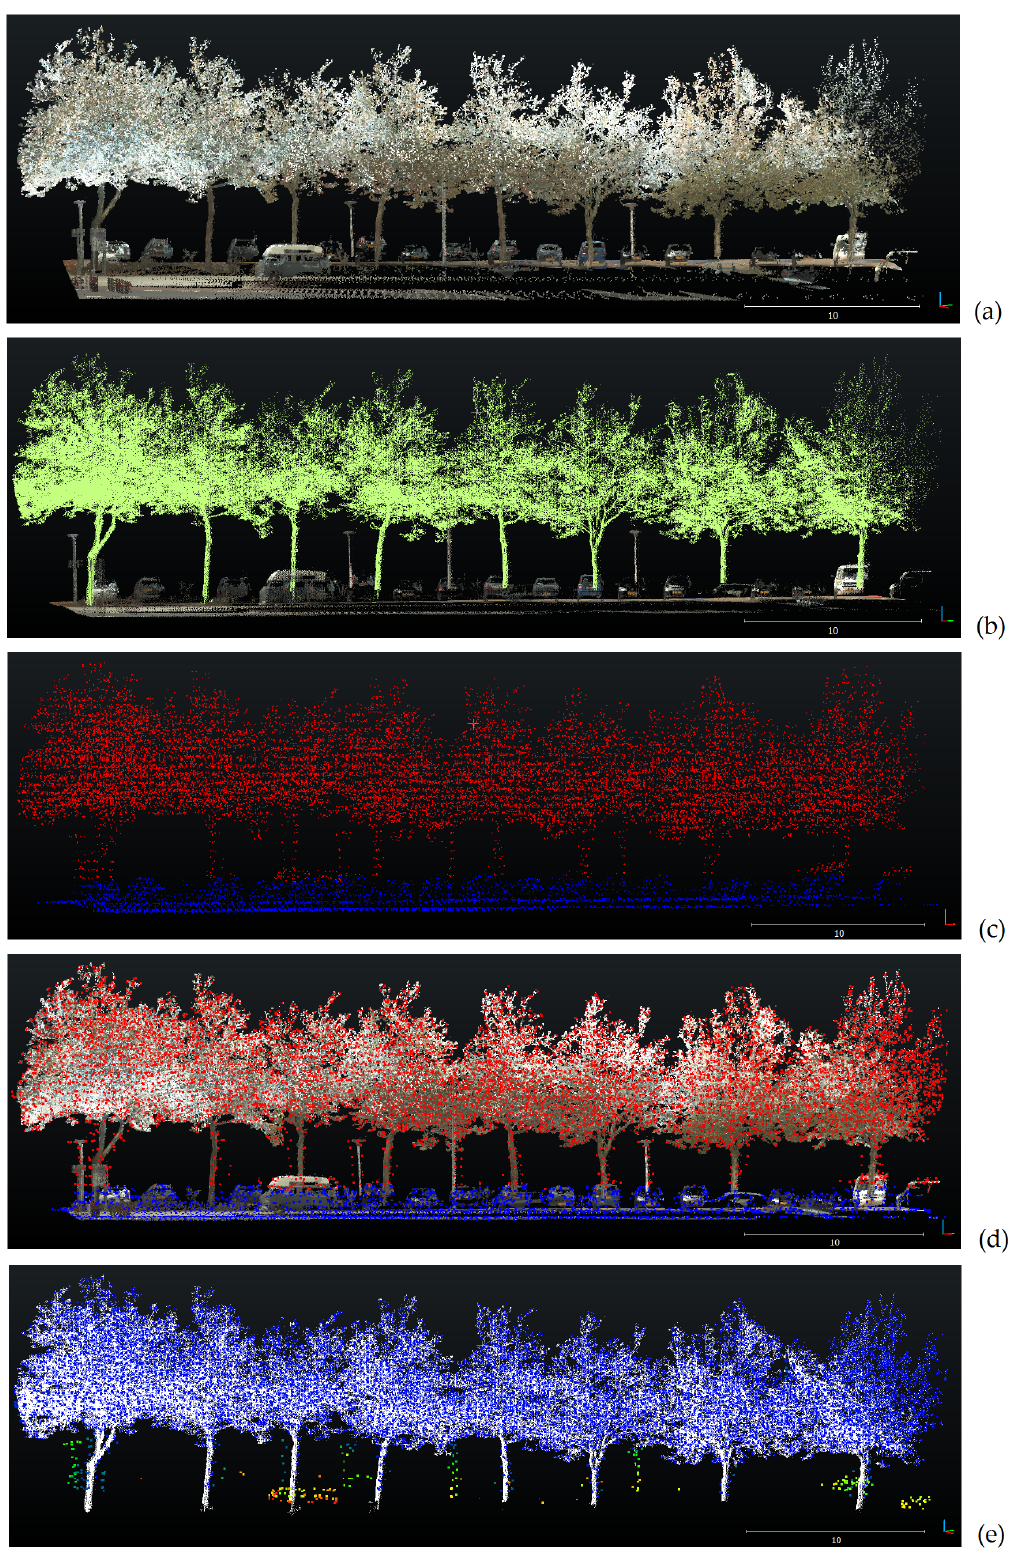
Figure 9: The classification performance on a small section of the MLS point cloud is represented with details. (a) The MLS point cloud section, (b) The manually labelled tree points in the MLS point cloud section (green points are chosen as benchmark for performance calculation), (c) The subsampled and automatically classified point cloud (red points are from the ’tree’ class and blue points are from the ’non-tree’ class), (d) The subsampled and automatically classified point cloud is shown together with the original MLS point cloud, (e) The benchmark points (in white color) and the automatically classified points are shown together (blue points are accepted as true detection, the warmer colors are accepted as false detection since they are further away from the benchmark cloud). This contribution has been peer-reviewed. The double-blind peer-review was conducted on the basis of the full paper. Editors: S. Oude Elberink, A. Velizhev, R. Lindenbergh, S. Kaasalainen, and F. Pirotti